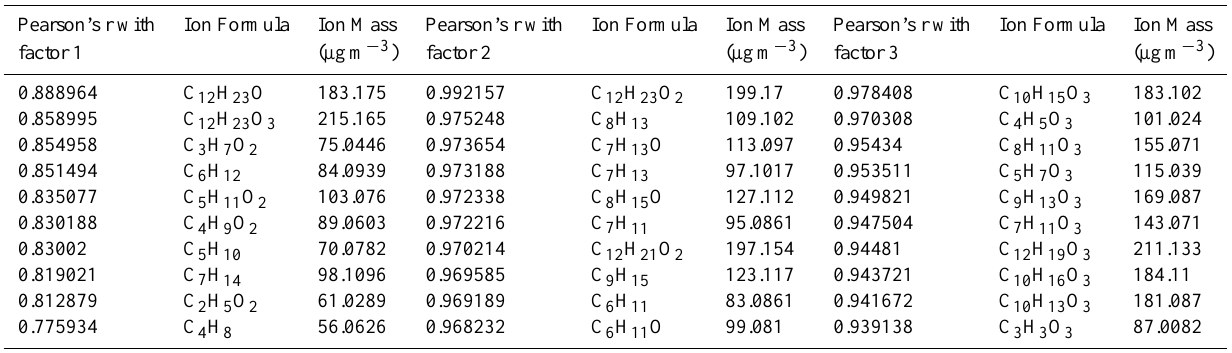
Table 3. HR-ToF-AMS ions with highest Pearson’s r values for f peak = 0 . 2 solution. Pearson’s r with Ion Formula Ion Mass Pearson’s r with Ion Formula Ion Mass Pearson’s r with Ion Formula Ion Mass factor